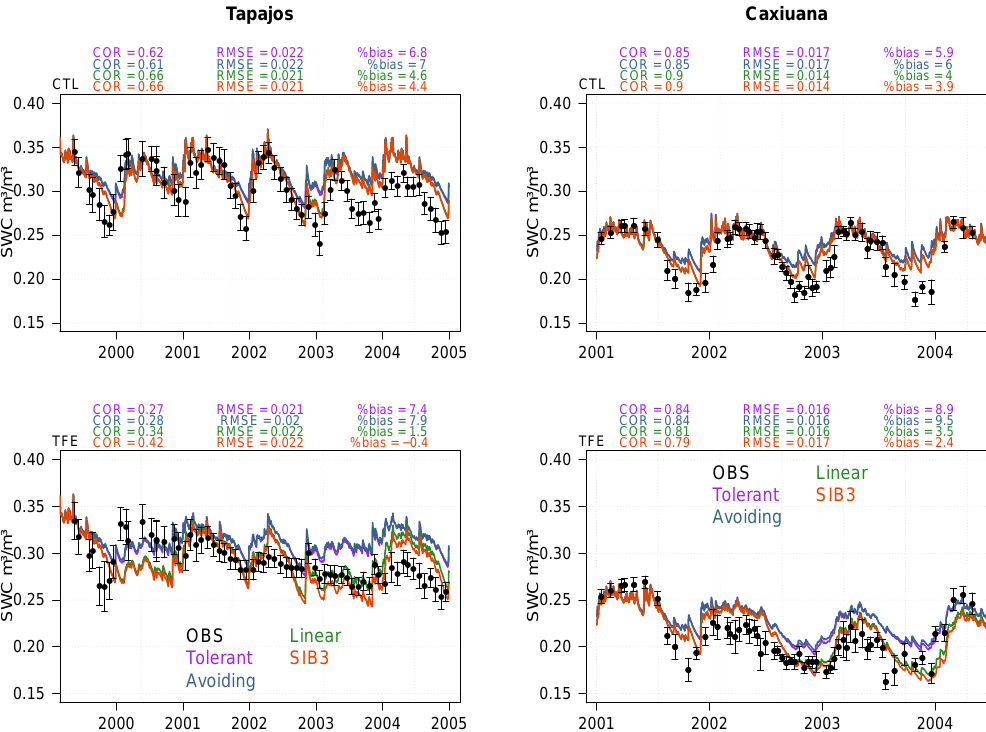
Figure 3. Daily observed and simulated soil water content with the four water stress functions (WSFs) at Tapajós (left) and Caxiuanã (right) Figure 3 – Daily observed and simulated Soil Water Content with the 4 WSF at Tapaj´os (left) and Caxiuan˜a (right) for for both control (CTL) (top) and throughfall exclusion (TFE) (bottom) plots. The soil water content (SWC) measured at the TFE plots were both CTL (top) and TFE (bottom) plots. The SWC measured at the TFE plots were rescaled to have identical SWC than the rescaled to have the same SWC as that of the CTL plots during the baseline CTL plots during the baseline year.